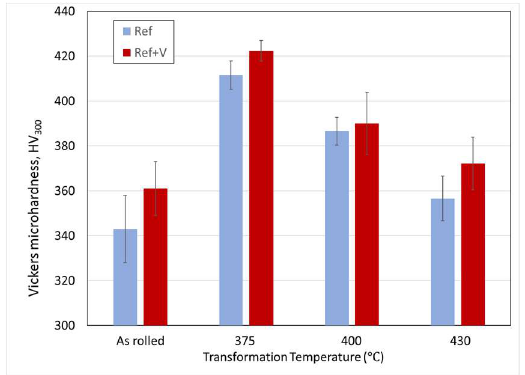
Figure 3. Vickers microhardness data from air-cooled as-rolled and isothermally transformed samples.